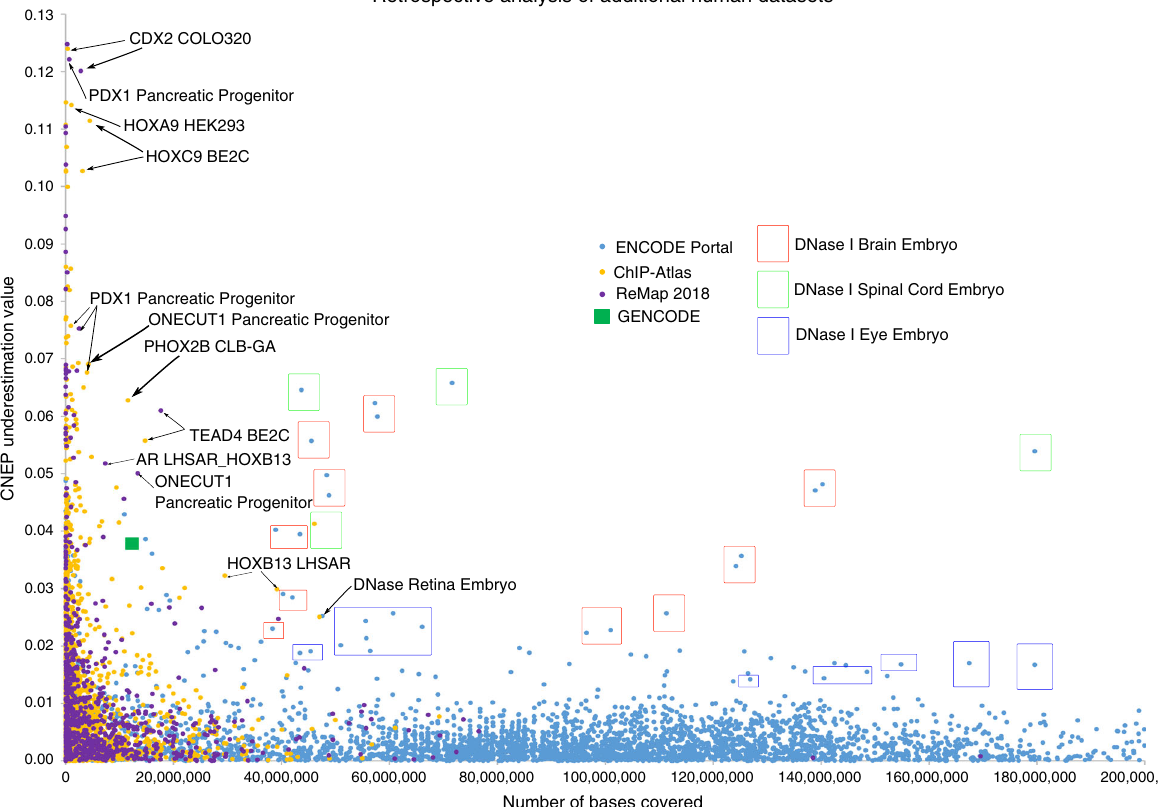
Fig. 5 Retrospective analysis of information in additional human datasets. Scatter plot of additional human datasets in a retrospective analysis. The x - axis is the number of bases covered by the dataset. The y -axis is the CNEP underestimation value for the dataset. Selected datasets with a high combination of base coverage and CNEP underestimation values are labeled or placed in a box if they correspond to a DNase I hypersensitivity experiment of embryonic brain, spinal cord, or eye. The color of the box corresponds to brain, spinal cord, or eye as indicated in the legend. The color and shape of the points are based on whether the point corresponds to a ChIP-Atlas, ENCODE portal, or ReMap 2018 dataset or the set of new GENCODE exons between v19 and v28. Only datasets with a positive underestimation value are shown. Datasets covering more than 200 million base pairs are not shown, but all had an underestimation value of <0.01. Three datasets that had an underestimation value >0.13 are not shown, but all covered <9000 base pairs. Versions of this plot showing negative CNEP underestimation values, for input features used by CNEP to generate the predictions, and for shuf fl es of additional datasets can be found in Supplementary Fig. 21. Source data are provided as a Source Data fi